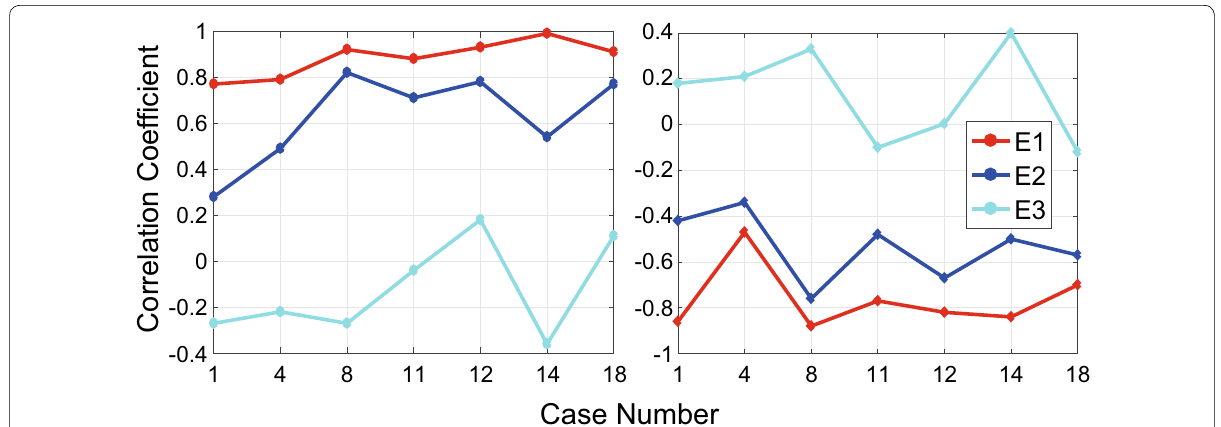
Fig. 3 Correlation coefficient between electron fluxes and (left) Kp index and (right) Dst index for channels E1 (red), E2 (blue), and E3 (light blue) for selected